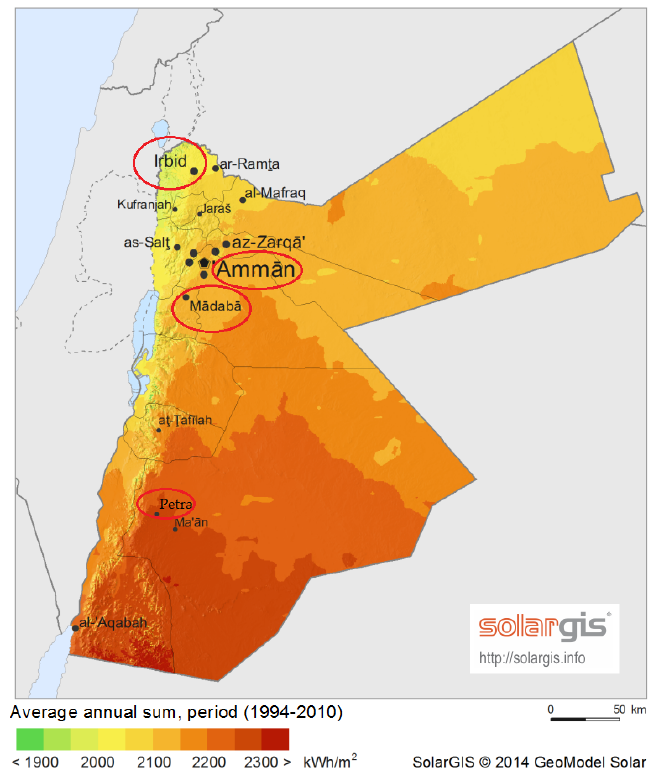
Figure 2. Map of Jordan with the four installed absorption chillers, encircled by red circles, accompanied with the annual radiation on horizontal surfaces. Reproduced with permission from [22], Copyright AIP Publishing, 2016.